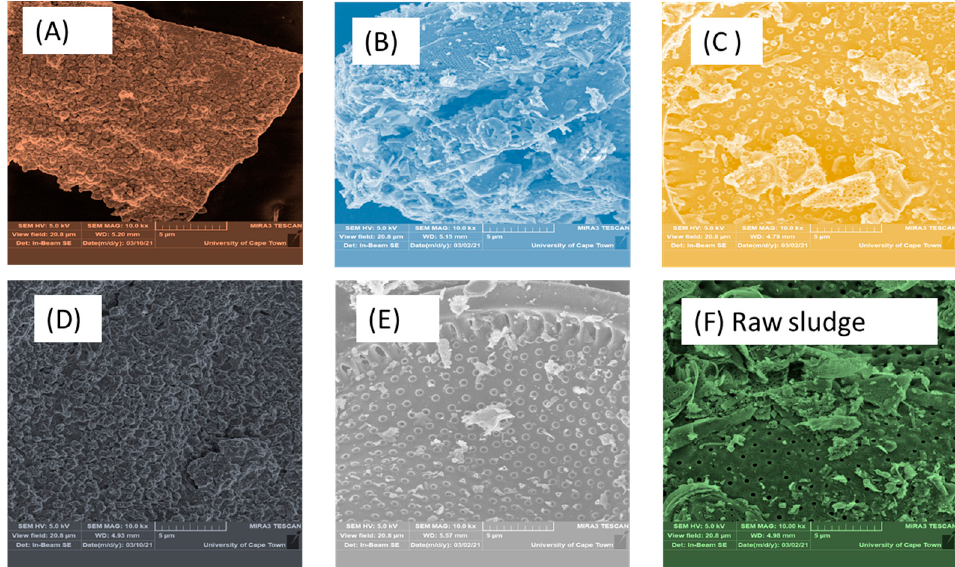
Figure 1. SEM images for post-sludge bioreactors A–D charged with 2 g of ( A ) Fe 2 O 4 -TiO 2 ; ( B ) Cu- Fe 2 O 4 ; ( C ) Fe 3 O 4 ; and ( D ) Chitosan-Fe 2 O 4 /TiO 2 MNPs, whereas bioreactor E is a control: ( E ) no MNPs and ( F ) raw sludge.